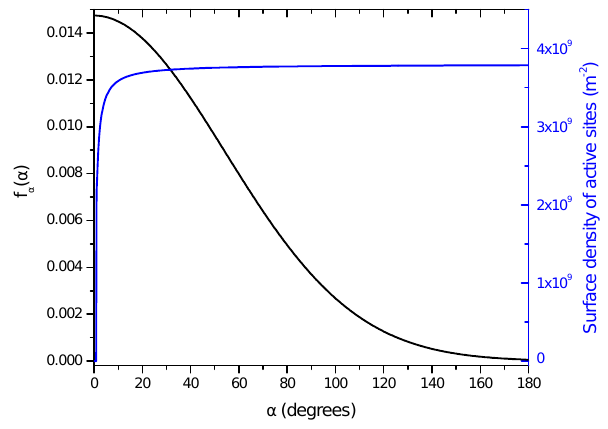
Fig. 7. Probability distribution function for the PDF- α model and surface density of active sites, ρ(α) , for the active site model. Shown are the results for kaolinite particles.